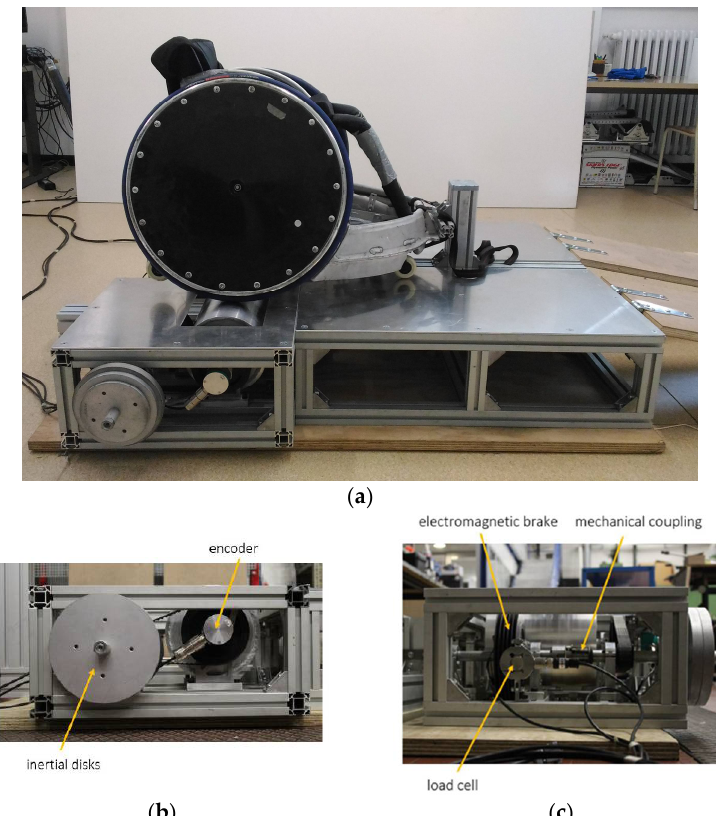
Figure 1. The inertial drum ergometer used for the tests: ( a ) overall configuration with the wheelchair on; ( b ) a detail of the encoder and the inertial disks; ( c ) a detail of the brake, load cell and mechanical coupling assembly.